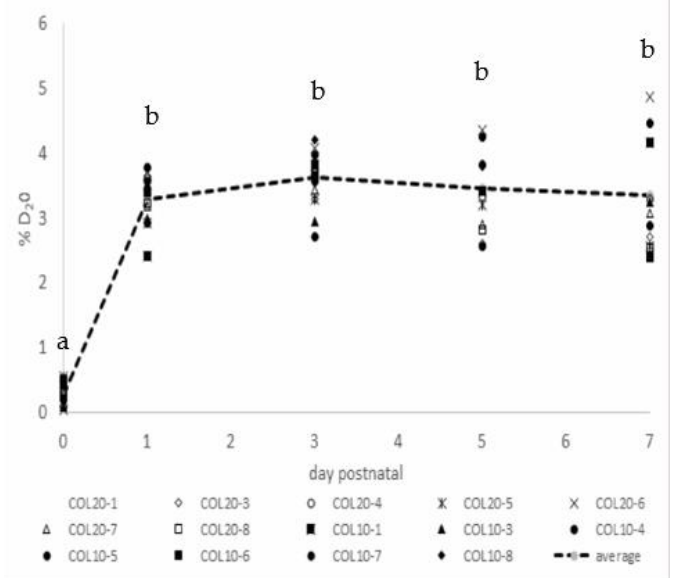
Figure 4. The effect of day and colostrum treatment on the proportion of parenchyma composed of epithelial tissue and percent epithelial and stromal cell proliferation index. ( A ) Proportion of parenchymal tissue composed of epithelium (parenchymal epithelial area; PEA) and ( B ) percent of epithelial and stromal cells in parenchymal compartment stained with KI67 as a marker of proliferating population in mammary tissue of baseline ( n = 6; gray) animals collected immediately after birth and in neonatal piglets fed 10% (COL10; n = 7; black) or 20% (COL20; n = 6; white) of birth weight of colostrum over the first 24 h postnatal, returned to sow to suckle and then euthanized on day seven postnatal. Within the boxplot, the ‘x’ indicates mean, and line indicates median. Different letters indicate a significant difference at p < 0.05.